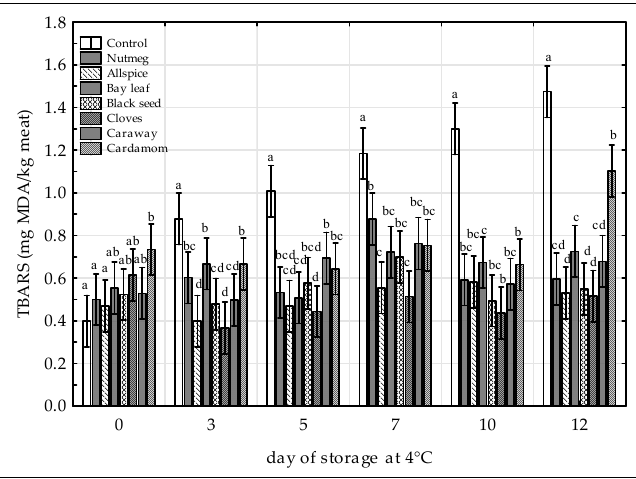
Figure 2. Effect of various spice extract treatments on thiobarbituric acid reactive substances (TBARS) in raw ground chicken legs during 12 days of storage at 4 °C. Means with the various superscript within the same day are significantly different ( p ≤ 0.05, Duncan’s test). Vertical bars indicate 0.95 confidence intervals.